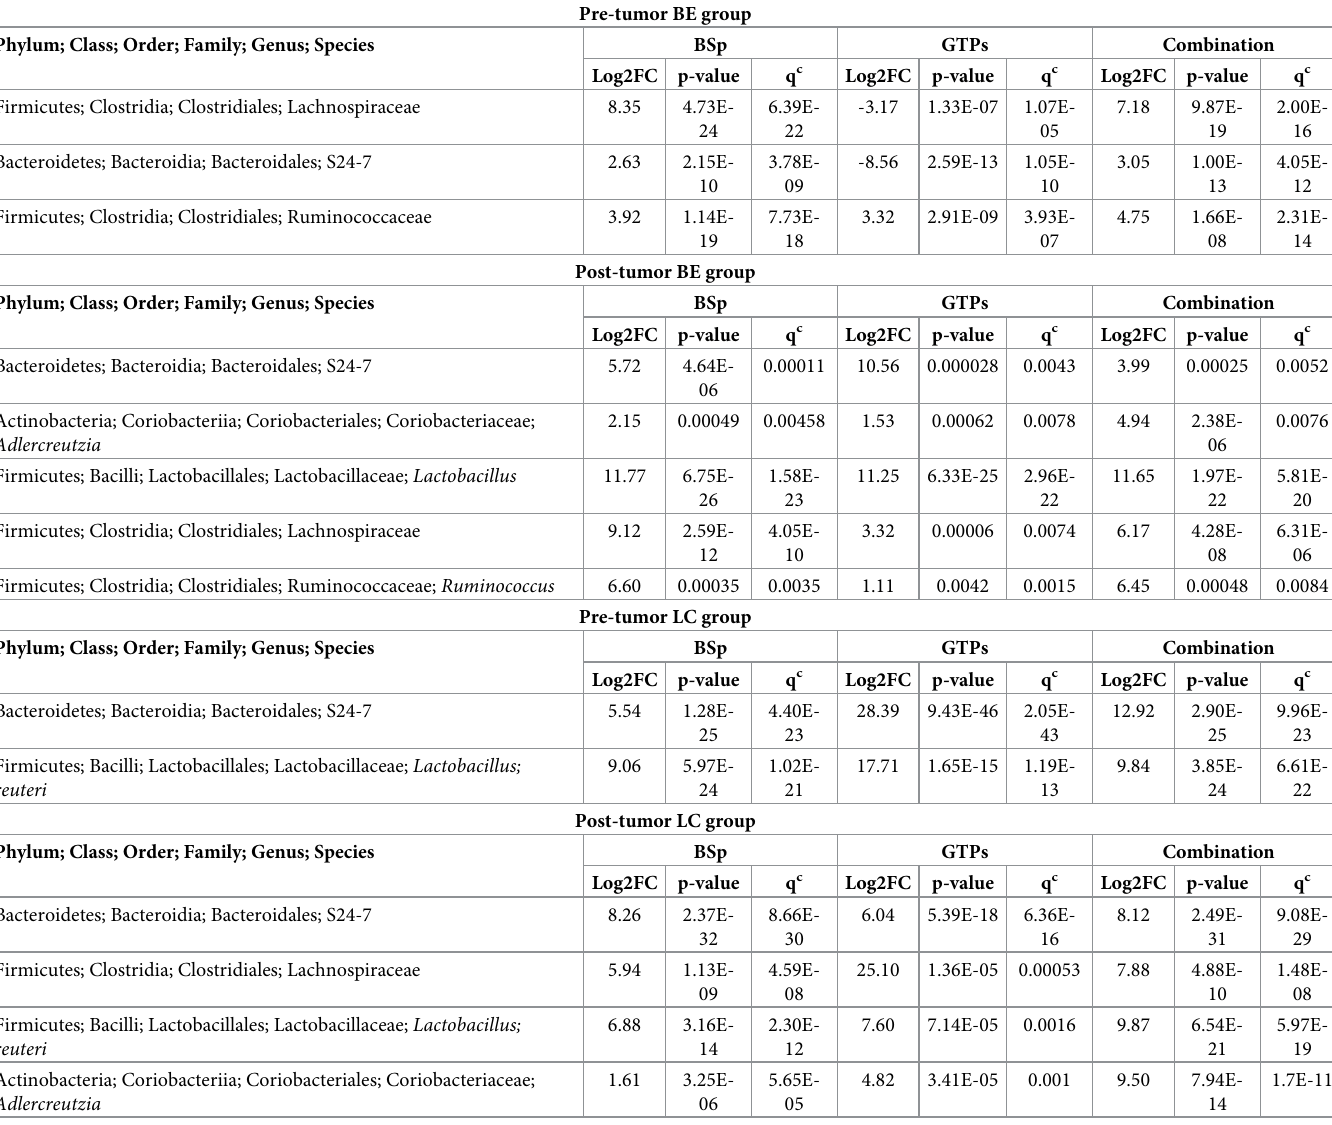
Table 1. Differentially abundant bacterial species before and after the onset of tumor in BSp-fed, GTPs-fed and combination-fed mice versus control-fed mice of the both BE and LC groups.